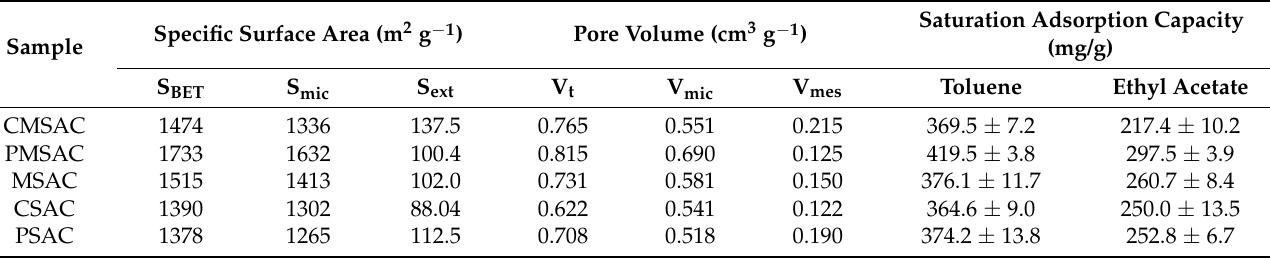
Table 1. The textural characteristics and adsorption capacities of